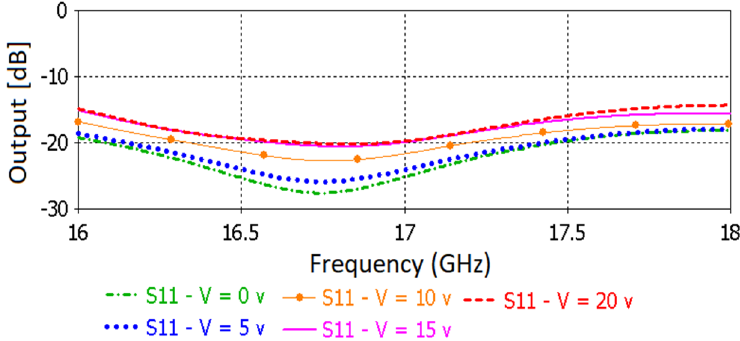
Figure 6. Reflection coefficient of the SIW variable phase shifter for five different biasing voltages.